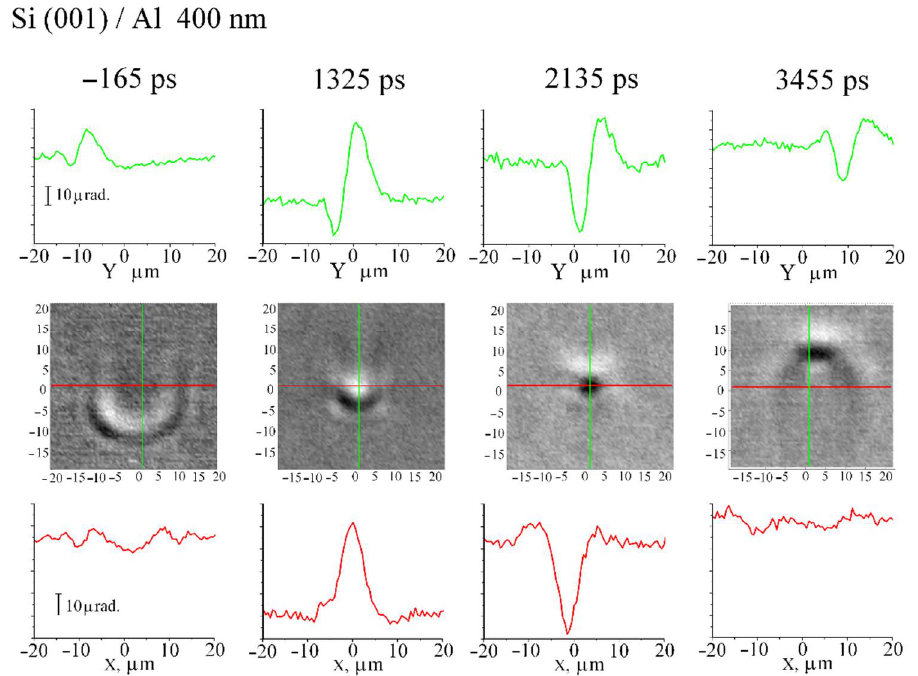
Figure 8. Center block of pictures: SAW field on silicon with orientation (001) covered by aluminium film at half-ring excitation at several time moments. Top block and bottom block of pictures shows SAW profile along green and red lines, respectively.